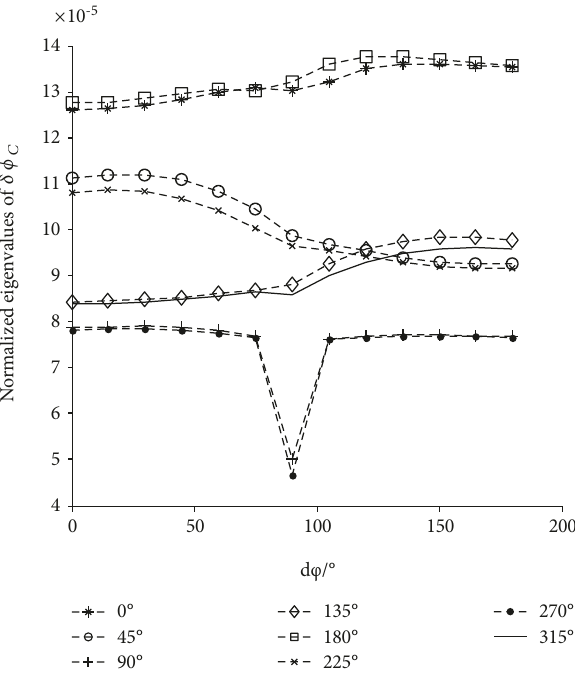
Figure 11: Normalized eigenvalues of the estimated current direction error under di ff erent current directions.